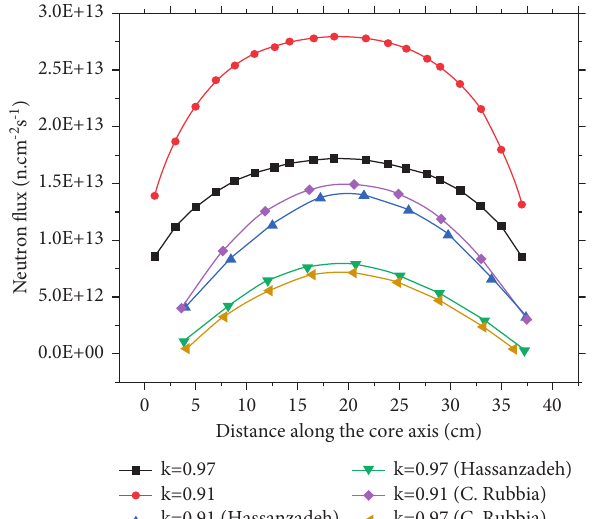
Figure 3: The axial distributions of the neutron flux with UZrH fuel mixture placed in the light water for the solid lead target.